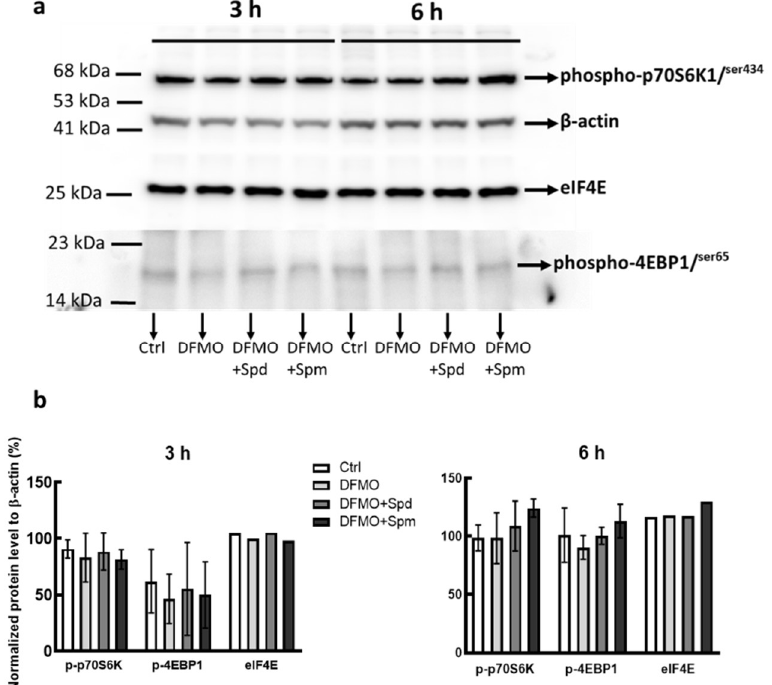
Figure 1. Effect of polyamine modulation of mTORC1 downstream proteins phosphorylation. MDA-MB-231 cells were grown in 5 mM DFMO containing growth medium with no amino acids supplementation for 48 h. Cells were